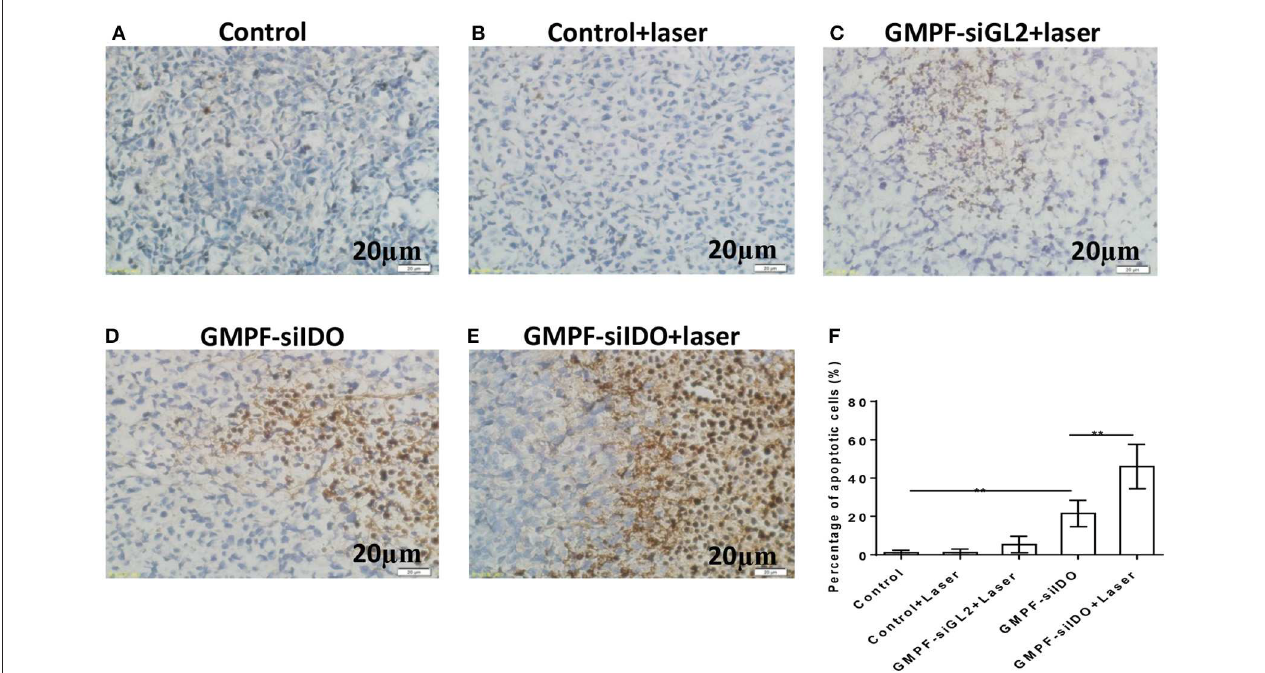
FIGURE 6 | Enhanced apoptosis of tumor cells by photothermal-immunotherapy. LLC lung cancer-bearing mice were treated with PBS (control), GMPF-siGL2, or GMPF-siIDO, with or without laser irradiation. Tumor tissues were collected, and apoptosis was detected by TUNEL assays (A–E) and percentages of apoptotic cells were calculated (G) . Error bars represent the standard deviation of three experiments. Error bars represent the standard deviation of three experiments (** P <